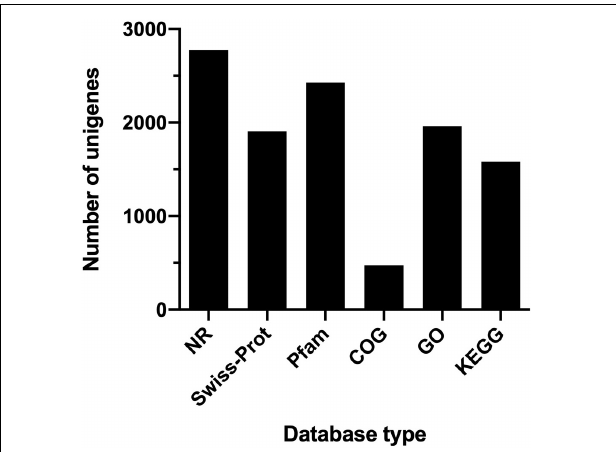
FIGURE 2 | The statistic histogram of basic functional annotation of genes in T. versutus D301. The horizontal axis represents different database used for annotation. The vertical axis represents the number of genes annotated by different database. The total number of coding genes is 2,788 in T. versutus